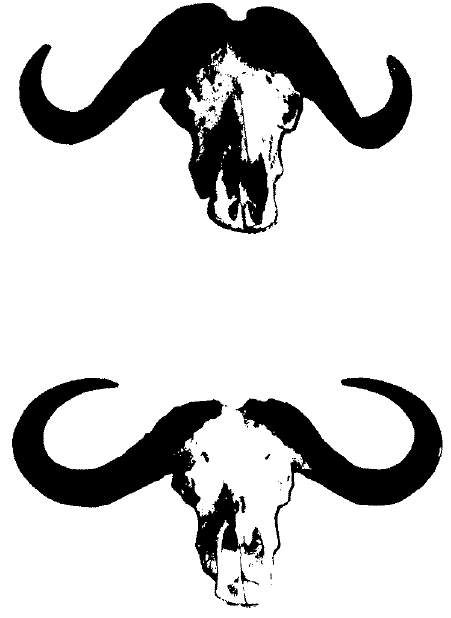
Fig. 2. Examples of broomed (top) and non-broomed (bottom) buffalo